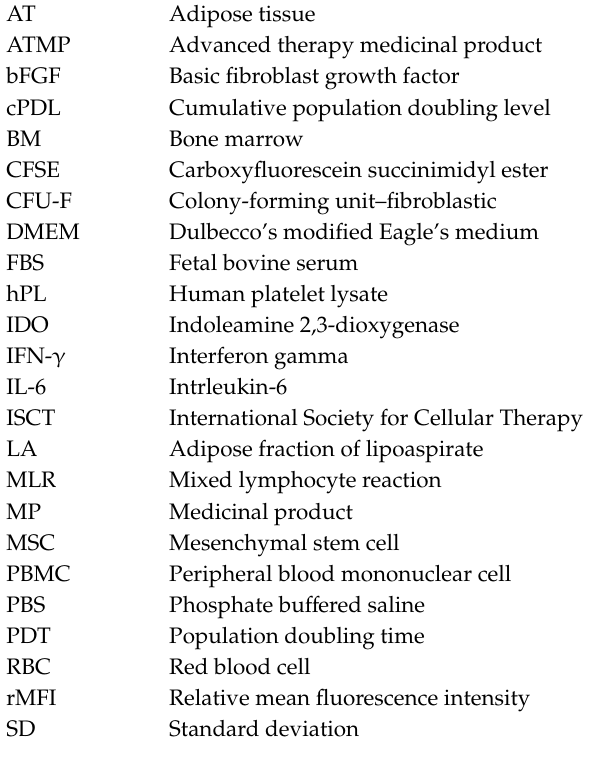
s1. Figure S1: Trilineage di ff erentiation potential of tissue-specific MSCs. Figure S2: Proliferative properties of tissue-specific MSCs during M2-M1 switch. Table S1: Expression of MSC markers in tissue-specific MSCs during the M2-M1